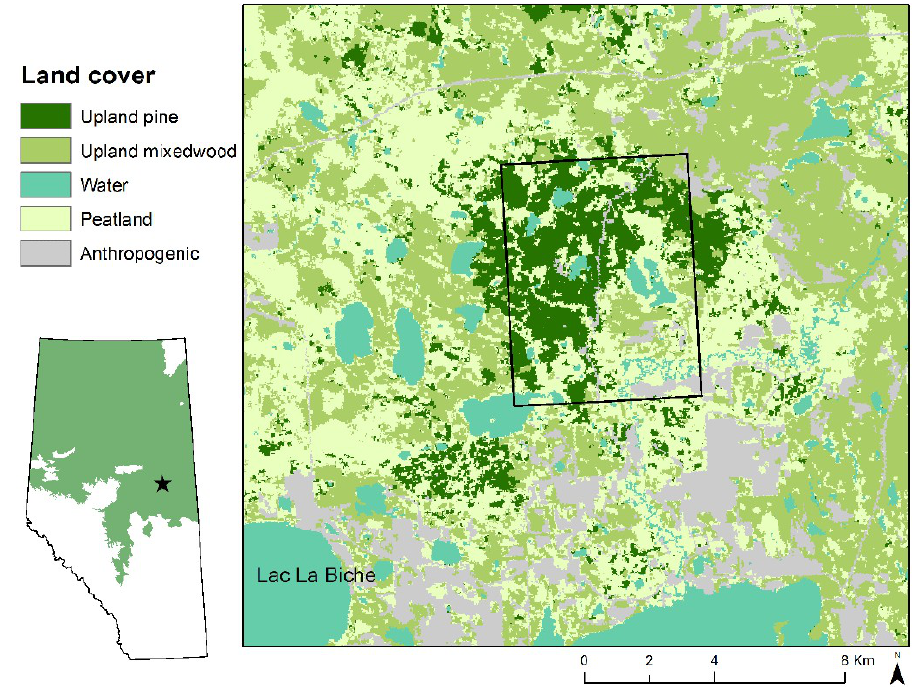
Figure 1. Location of study area. The study area is located north of Lac La Biche, Alberta, Canada in the south boreal transition zone (see black rectangular outline). Land cover classes modified from the enhanced wetland classification [21]. Inset map shows the extent of the boreal forest in Alberta, Canada.